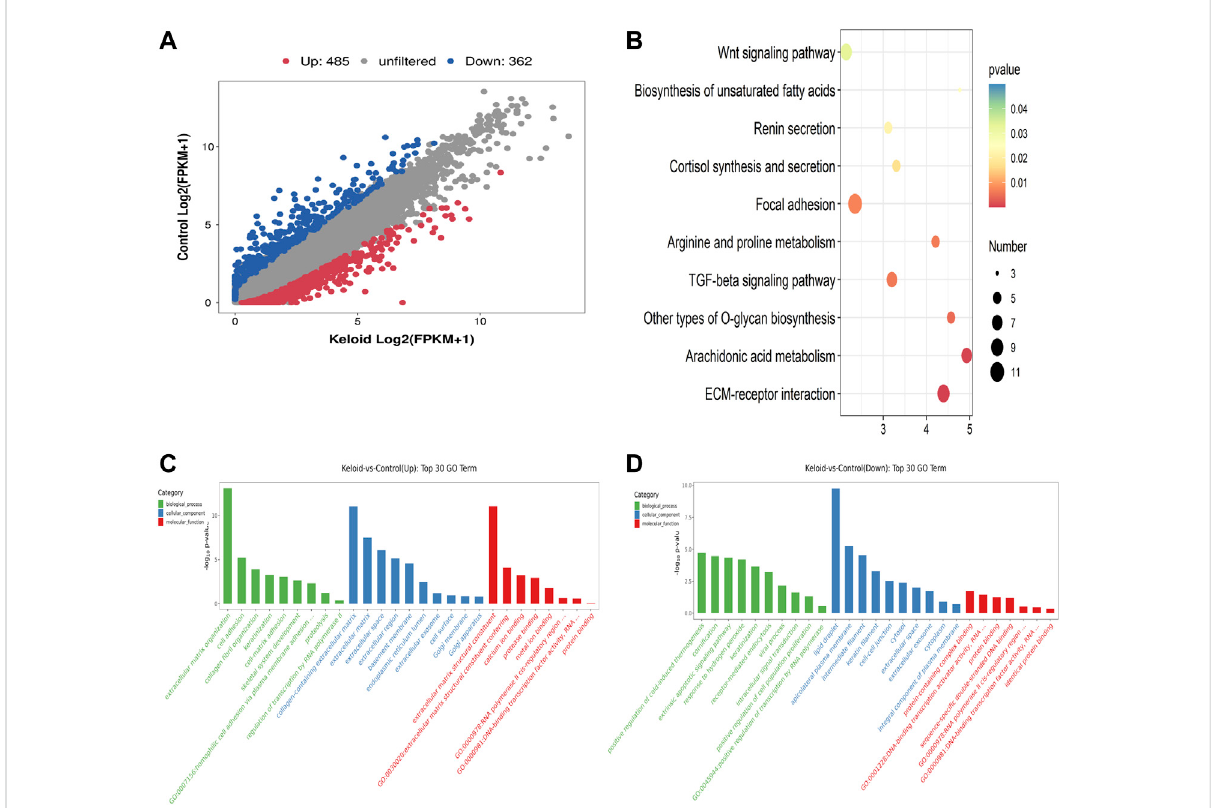
FIGURE 3 Differentially expressed genes (DEGs), KEGG, and GO items in keloid. (A) Scatter plot of the RNA-seq data between two groups. (B) Top ten pathways of the increased mRNA in the keloid samples compared with those in NS samples. (C) Overview of the distributions of the upregulated genes in various GO categories including biological process (BP), cellular component (CC), and molecular function (MF). (D) Overview of the distributions of the downregulated genes in BP, CC, and